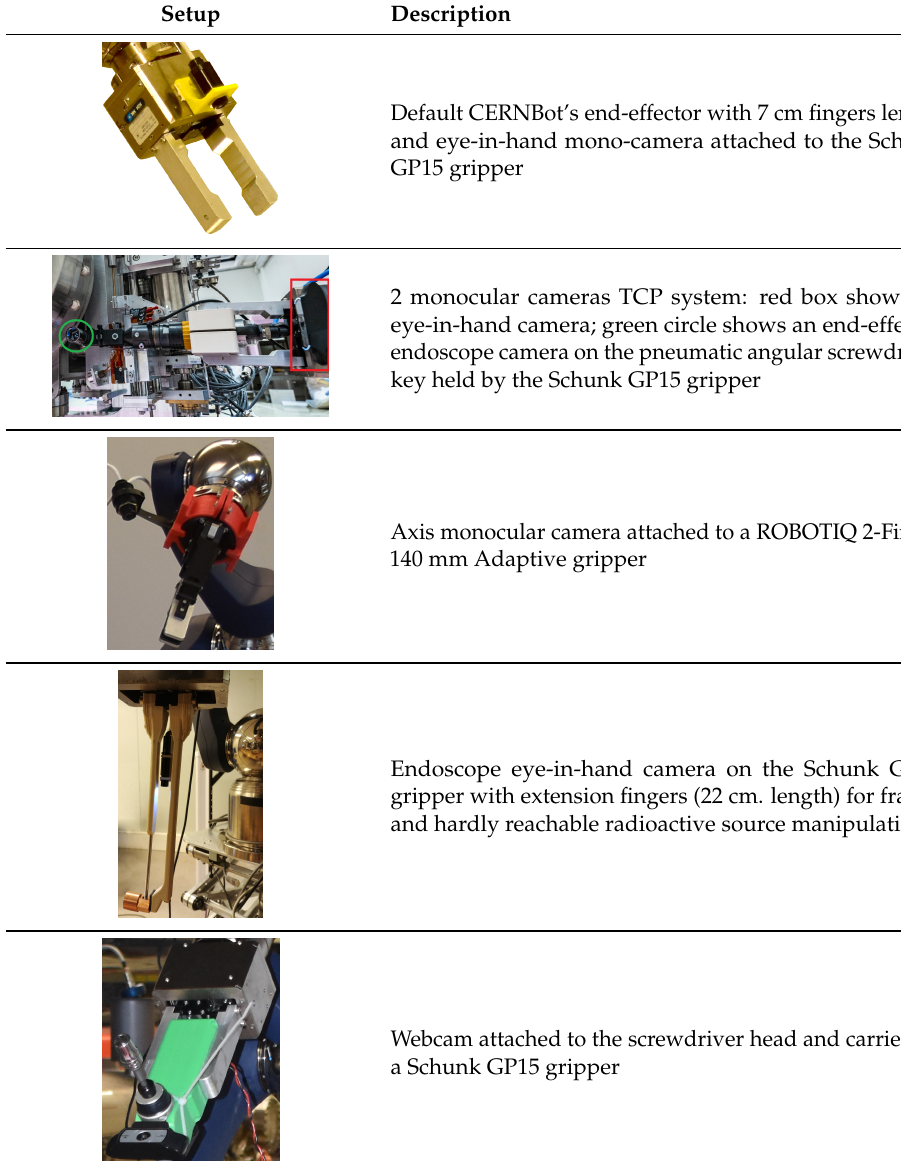
Table 2. Examples of grippers set and configuration of the